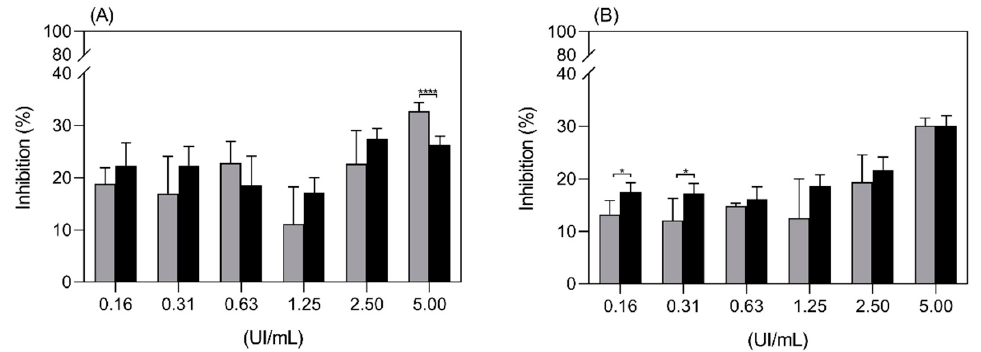
Figure 8. Inhibition of proliferation of the K562 cell line by ASP-enzymosomes (black bars) and ASP (grey bars) at 48 h ( A ) and 72 h ( B ). Each point is the mean of six replicates, ±SD, from one representative experiment. * p -value < 0.5 and **** p -value < 0.0001.